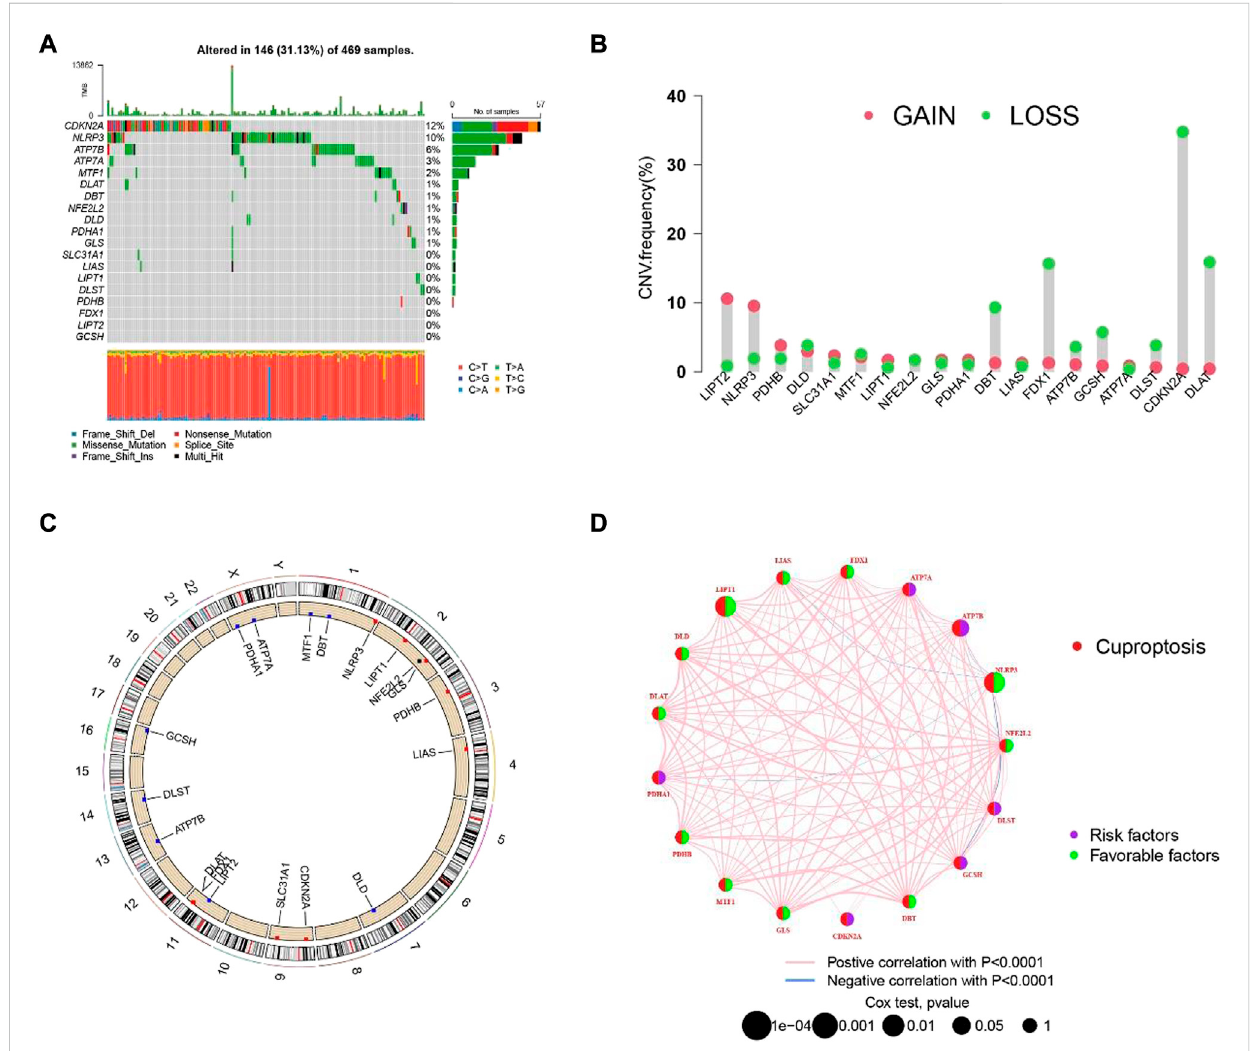
FIGURE 2 The hereditary characteristics and transcription changes of cuproptosis-related genes in melanoma. (A) Genetic alteration of cuproptosis-related genes in melanoma. (B) Cuproptosis of CNV gain, loss, and non-CNV among cuproptosis-related genes. (C) The circus plots show the position of cuproptosis-related genes in chromosomes. (D) The PPI network shows the prognosis of cuproptosis-related